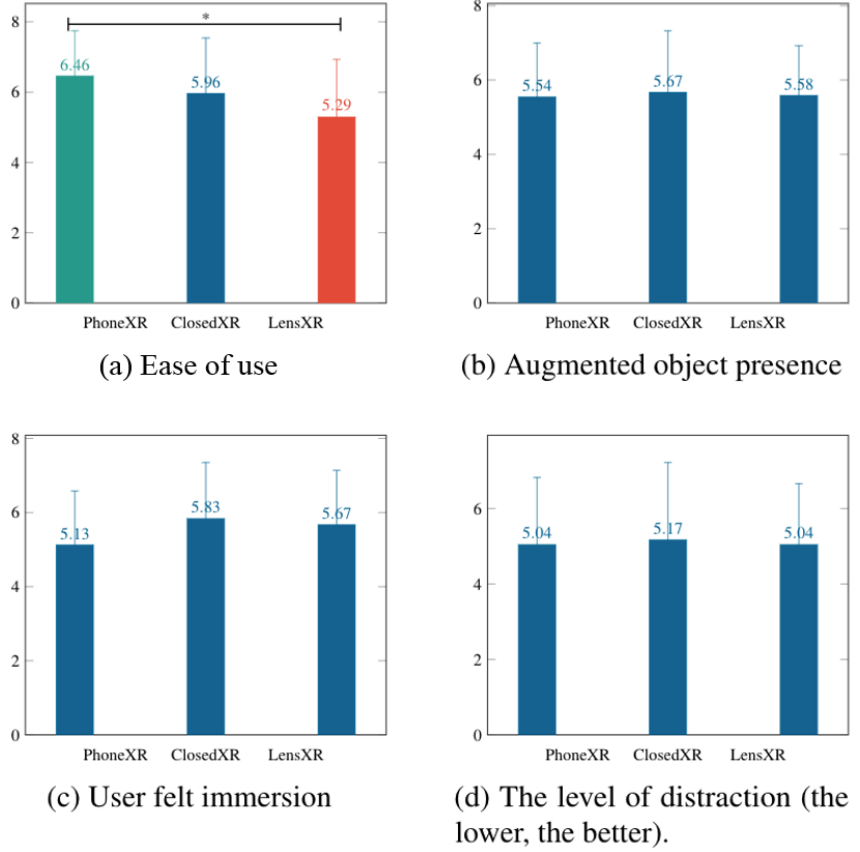
Figure 7. Survey results regarding the UX for the AR mode operation—statistical differences are indicated with the “*” mark and illustrated by color grouping. The vertical axes represent the subjective levels in the 7-point Likert